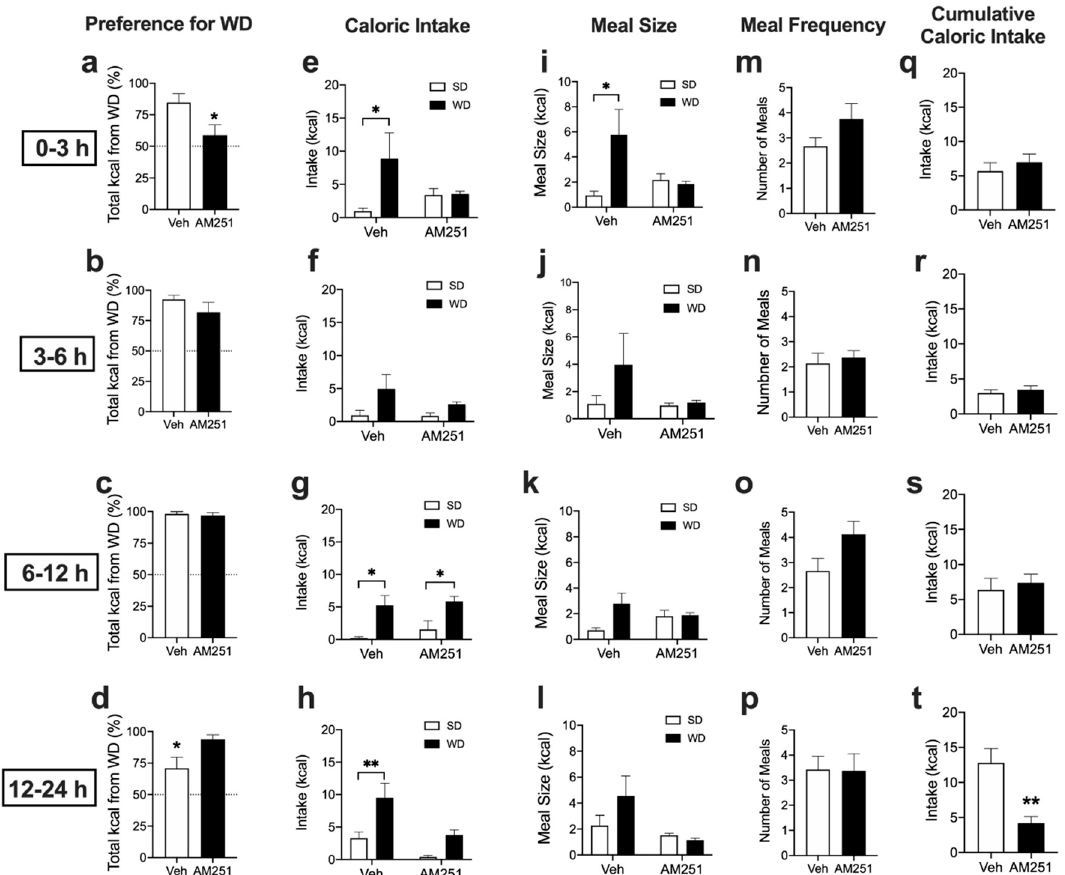
Figure 1. Cannabinoid CB 1 Rs control acute preferences for Western Diet. Veh = vehicle treatment; AM251 = 3mg per kg; SD = standard rodent chow; WD = western diet. Unpaired Student’s t -test, two-tailed ( a – d , m – t ); Two-way ANOVA with Holm-Sidak’s multiple comparison tests ( e – l ); * p < 0.05, ** p < 0.01. Results are expressed as means ± S.E.M; n = 7–8 per condition.